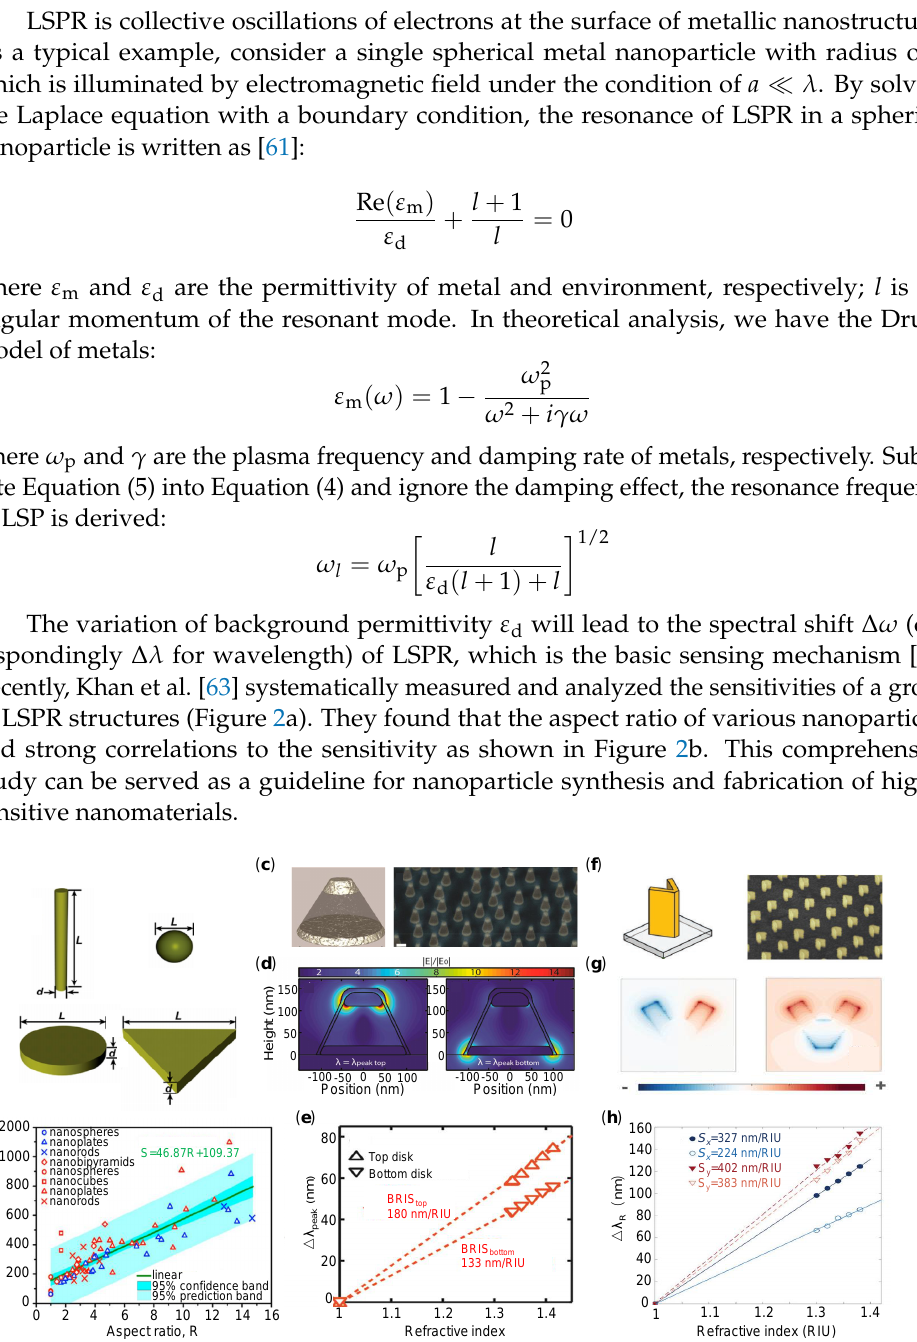
Figure 2. Localized surface plasmon resonance (LSPR) structures and sensing performance. ( a ) Vari- ous shapes of plasmonic nanoparticles. ( b ) Refractive index (RI) sensitivity of plasmonic nanoparticles of various sizes, shapes, and compositions. ( c ) Schematic (left) and scanning electron microscope (SEM) image (right) of the 3D nanoplasmonic sensor architecture. Two Ag nanodisks of different diameters and thickness are vertically separated by a thick SiO 2 spacer layer. ( d ) Electromagnetic field distribution by a normal-incidence plane wave at different resonance wavelengths. ( e ) Bulk RI sensitivity for top disk and bottom disk. ( f ) Schematic (left) and SEM image (right) of V-shaped antenna. ( g ) Transverse surface charge distribution. ( h ) Bulk sensitivity properties for different optical polarized light excitation in ( f ). Reprinted ( a , b ) with permission from Reference [63]. Reprinted ( c – e ) with permission from Reference [64]. Reprinted ( f – h ) with permission from Reference